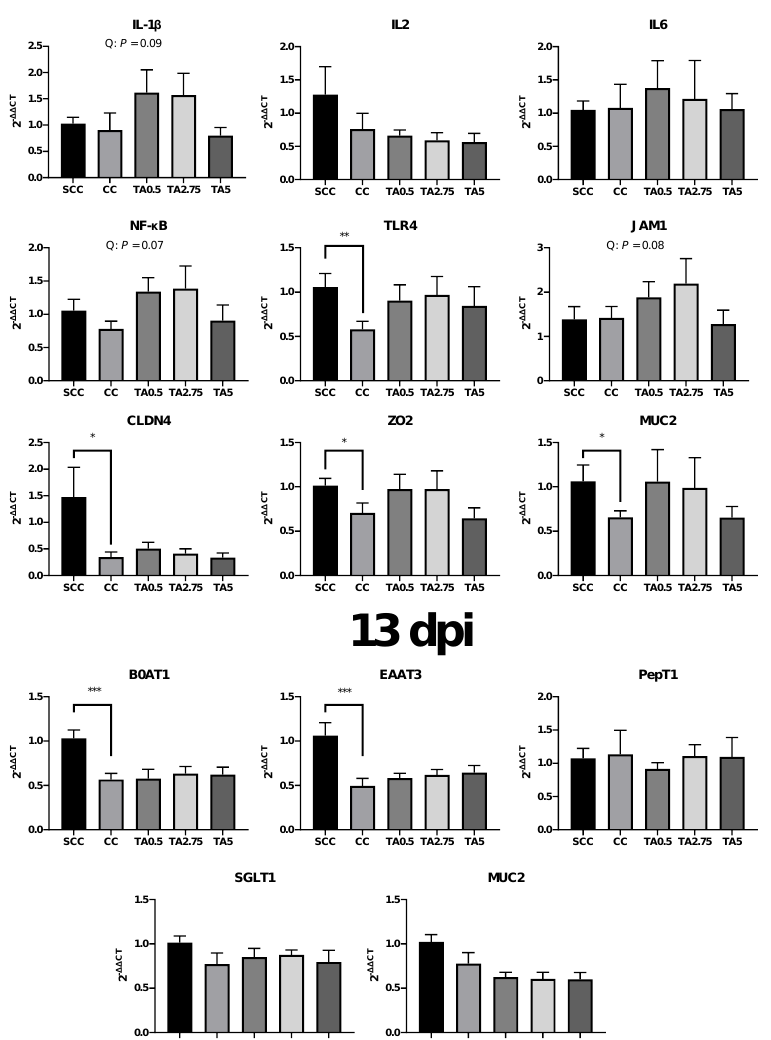
Figure 2. Relative mRNA gene expression in the jejunum at 6 days post-infection (dpi) (genes related to immune system, gut barrier integrity, and mucin) and 13 dpi (nutrient transporter and mucin) in the SCC ((sham-challenged control): broilers fed a control diet and administrated with phosphate buffered saline via oral gavage); CC ((challenged control): broilers fed a control diet and administrated with 10 4 of Eimeria maxima via oral gavage); TA0.5 ((tannic acid 500 mg/kg): CC + 500 mg/kg of tannic acid); TA2.75 ((tannic acid 2750 mg/kg): CC + 2750 mg/kg of tannic acid); TA5 ((tannic acid 5000 mg/kg): CC + 5000 mg/kg of tannic acid) groups. Each value represents the mean ± SEM. SCC was compared with CC (unpaired t -test), and the comparison was presented as * 0.05 < p < 0.10, ** p < 0.05, *** p < 0.01. Bars with different letters are significantly different ( p < 0.05) by PROC MIXED followed by the Tukey’s multiple comparison test among E. maxima -infected groups (CC, TA0.5, TA2.75, and TA5). Orthogonal polynomial contrasts analysis was conducted to see linear pattern (L) and quadratic pattern (Q) among Eimeria maxima challenged groups. GAPDH, glyceraldehyde 3- phosphate dehydrogenase; NFκB, nuclear factor kappa -light-chain-enhancer of activated B cells; IL, interleukin; JAM2, junctional adhesion molecule 2; ZO2, zonula occludens 2; CLDN4, claudin 4; SGLT1, sodium glucose transporter 1; PepT1, peptide transporter 1; B0AT1, sodium-dependent neu- tral amino acid transporter 1; EAAT3, excitatory amino acid transporter 3; GLUT2, glucose trans- porter 2; and MUC2, mucin 2.